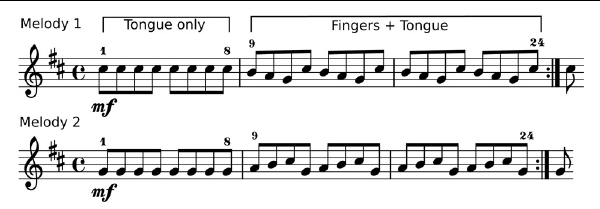
FIGURE 1 | Stimuli used for the production experiment. Two 24-tone melodies in E-flat notation. Note numbers 1–8 require tonguing only. In melody one (top) , note numbers 9–24 require sequential key-depression by left-hand fingers. In melody two (bottom) a sequential finger lifting is required to open the tone-holes of the